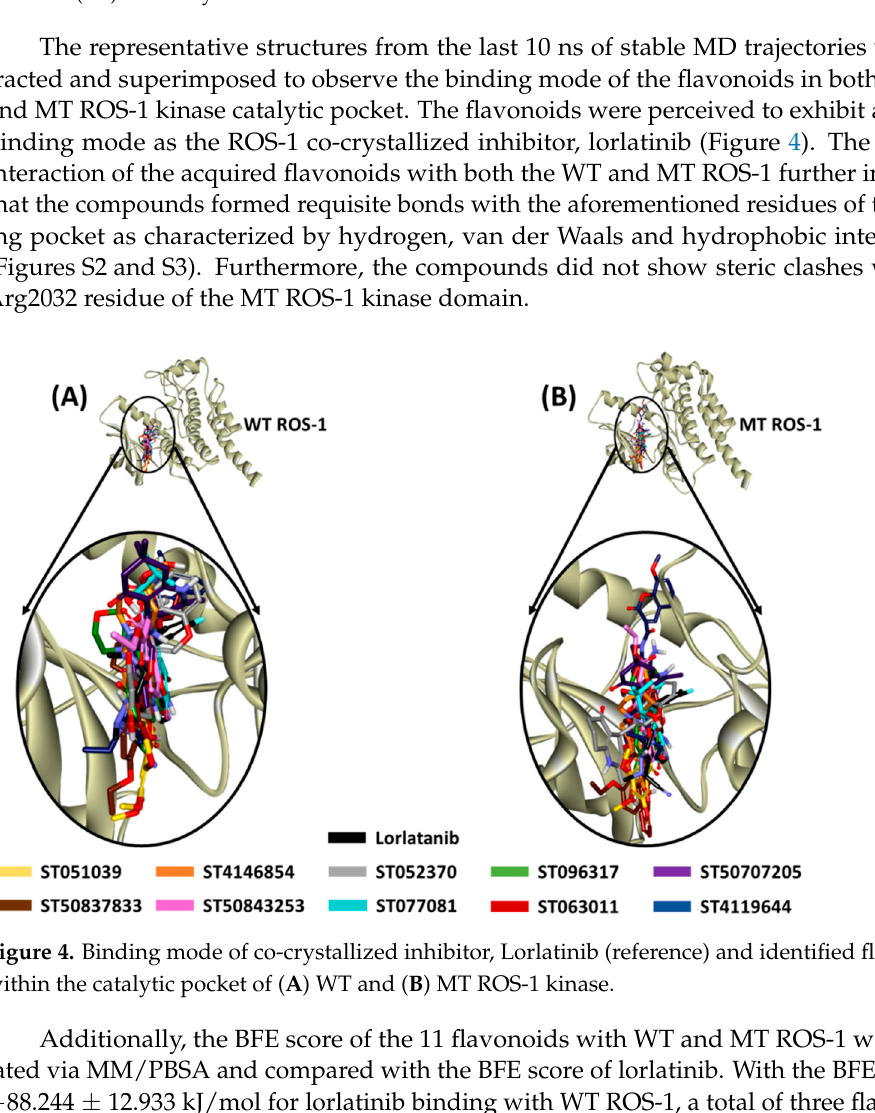
Figure 4. Binding mode of co-crystallized inhibitor, Lorlatinib (reference) and identified flavonoids within the catalytic pocket of ( A ) WT and ( B ) MT ROS-1 kinase.